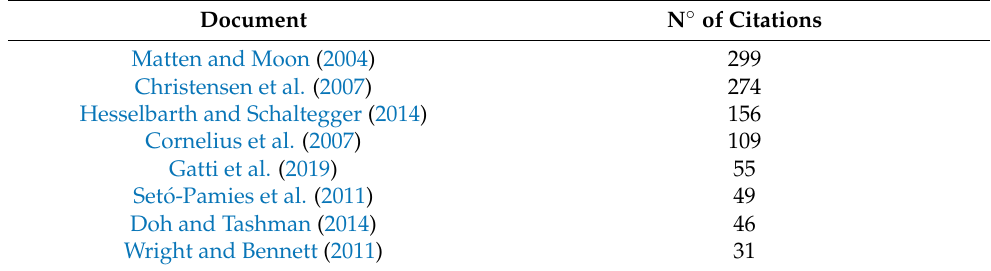
Table 4. Citations per authors/documents.